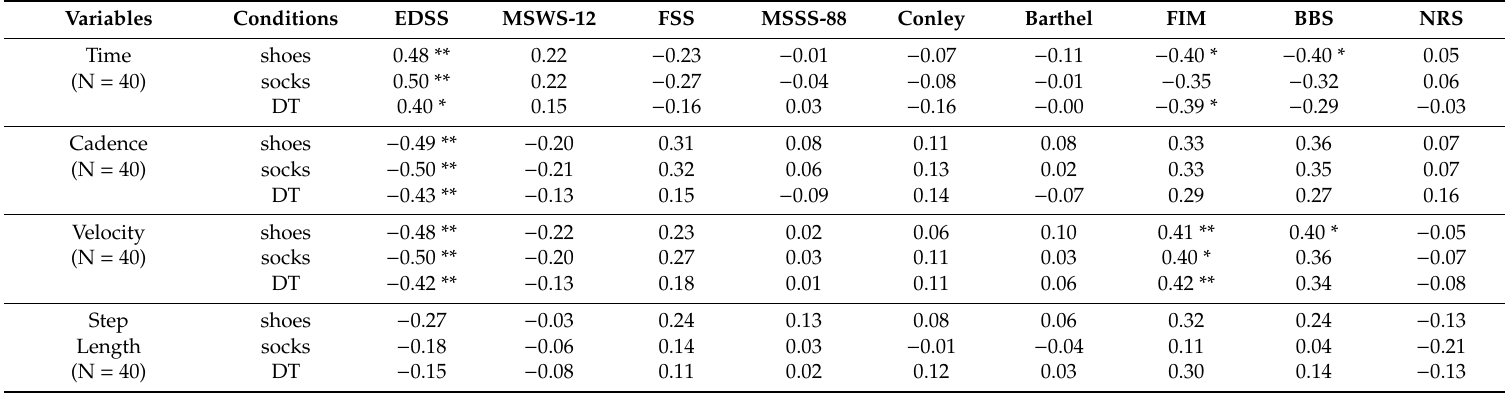
Table 2. Spearman’s correlation coe ffi cient between spatiotemporal parameters and clinical assessments in all the conditions. Spearman’s correlation was performed to explore the relationship between kinematics and clinical measurements.